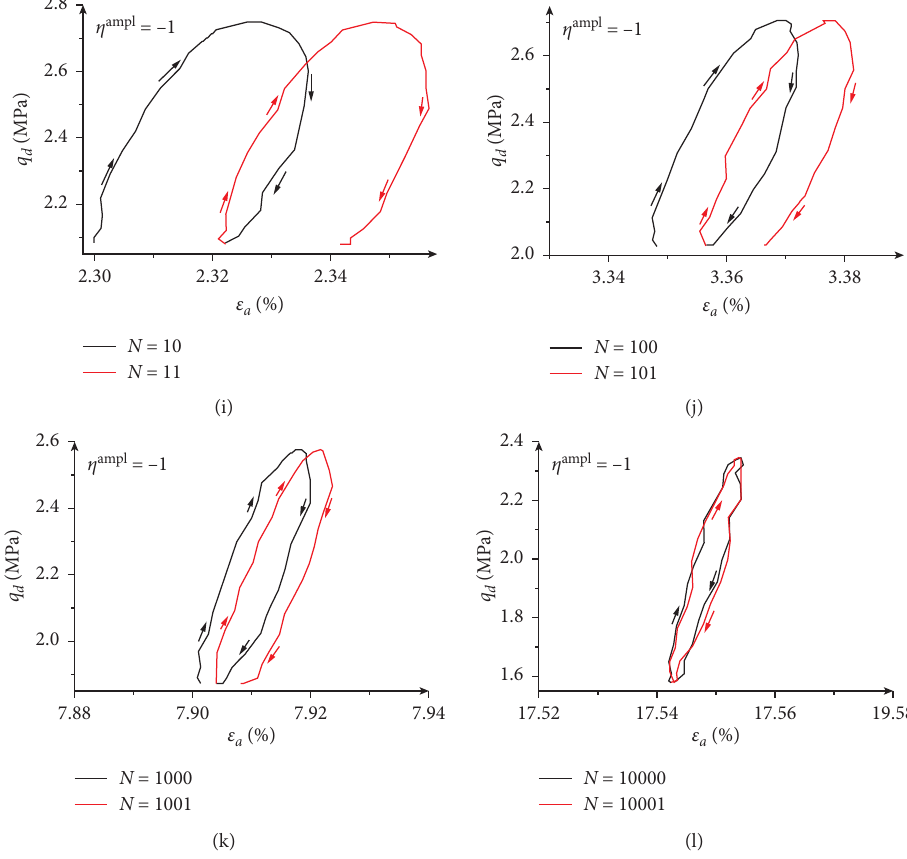
Figure 14: The hysteresis loops of different dynamic stress paths with the same half-length value of dynamic stress